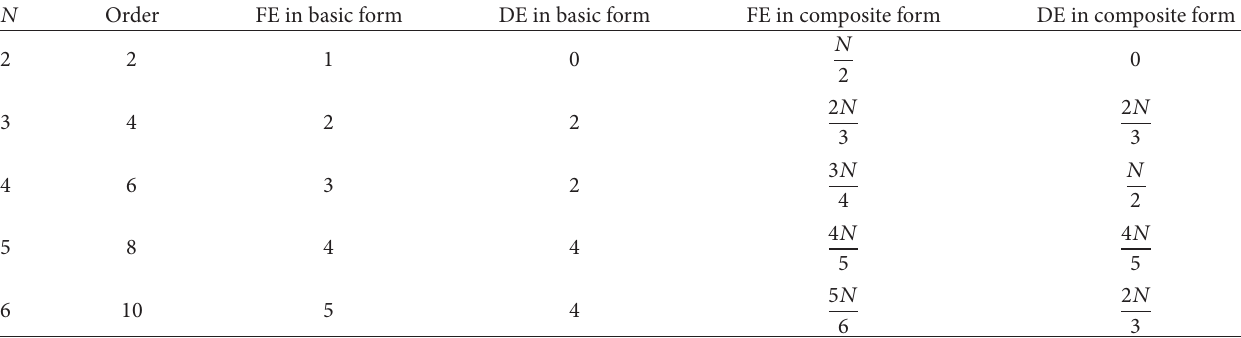
Table 3: Computational cost for ONC1.